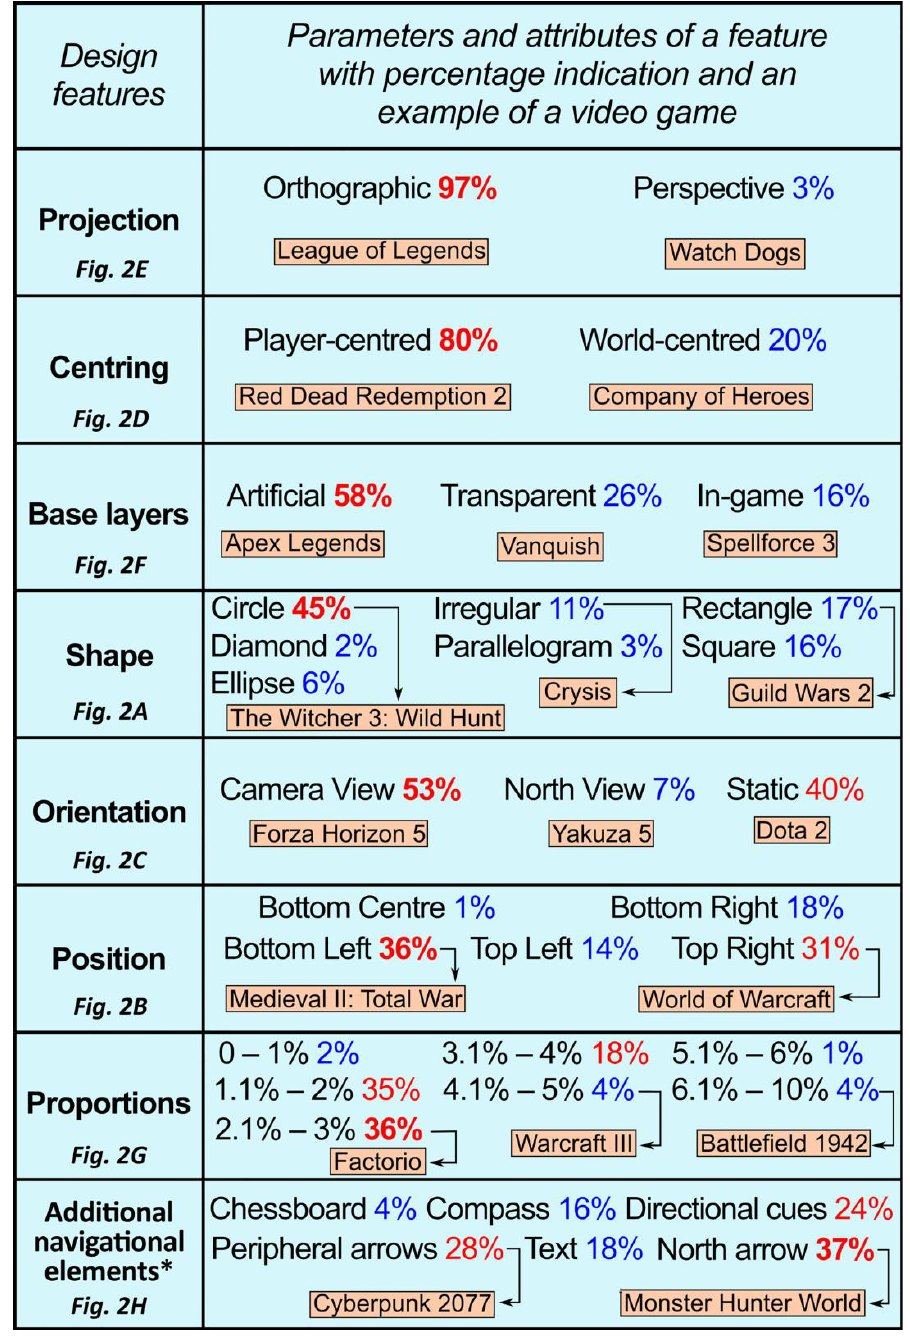
Figure 3. The percentage of use of a specific parameter of the mini-map with examples of video games according to their majority unambiguity. Bold red stands for the highest percentage, solid red for a value close to the highest, blue colour for values far from the highest. * One video game can use many additional navigational elements.